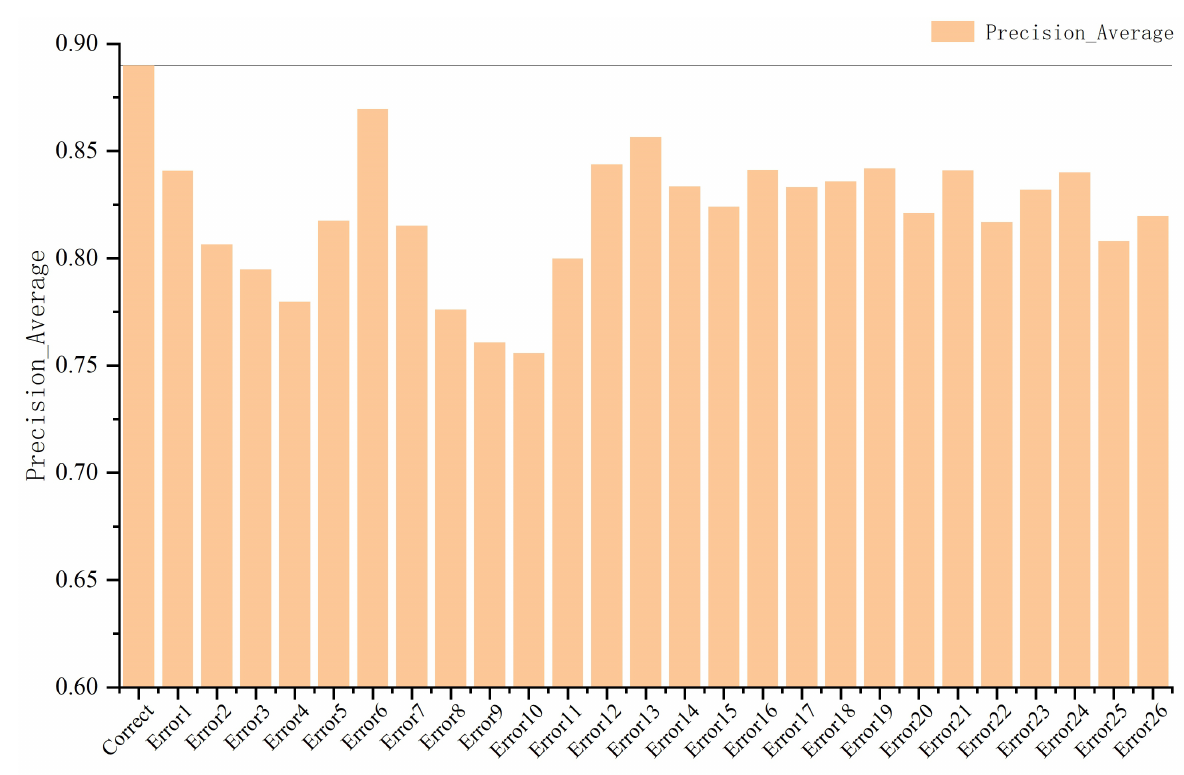
Figure A1. Average Precision under different cost sensitive factors α